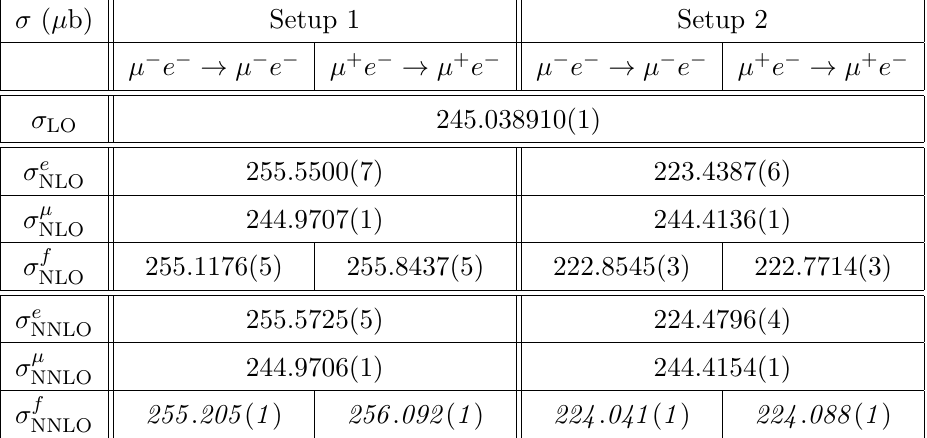
(cid:22) (cid:0) e (cid:0) and ! stand for (N)(N)LO